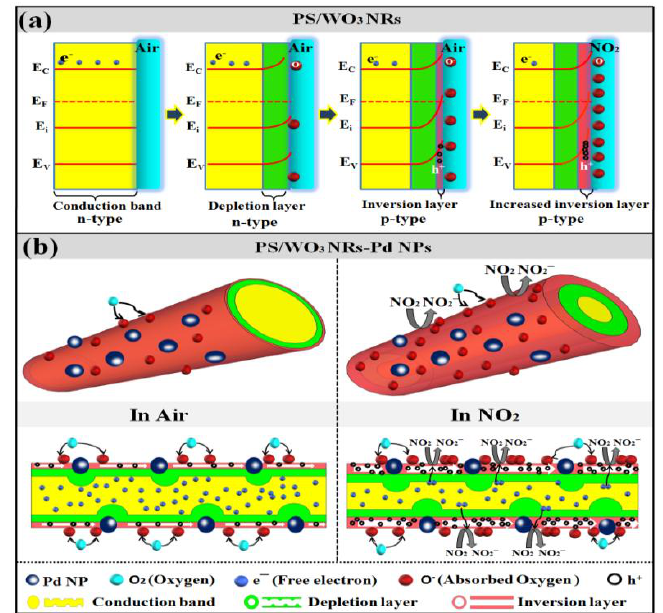
Figure 8. ( a ) Schematic energy-level diagram of the PS/WO 3 NRs sensor: from n-type semiconductor with flat band structure to n-type semiconductor with depletion layer, p-type semiconductor with inversion layer, and p-type semiconductor with increased inversion layer; ( b ) schematic adsorption-reaction gas-sensing mechanism of PS/WO 3 NRs–Pd NPs sensor: in air and in NO 2 .